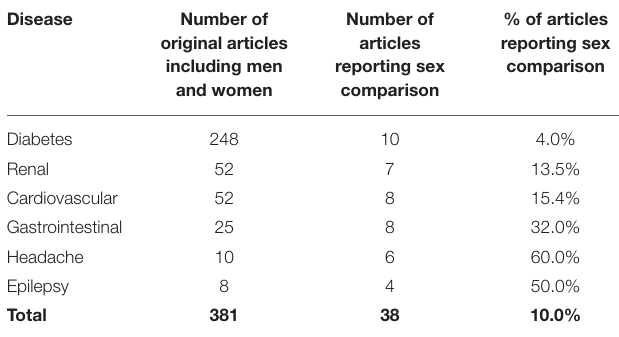
TABLE 2 | Number and percentage of the studies reporting data for both men and women or reporting comparison between the two sexes during Ramadan fasting in the patients with diabetes, renal, cardiovascular, gastrointestinal diseases, headache, and epilepsy. Disease Number of original